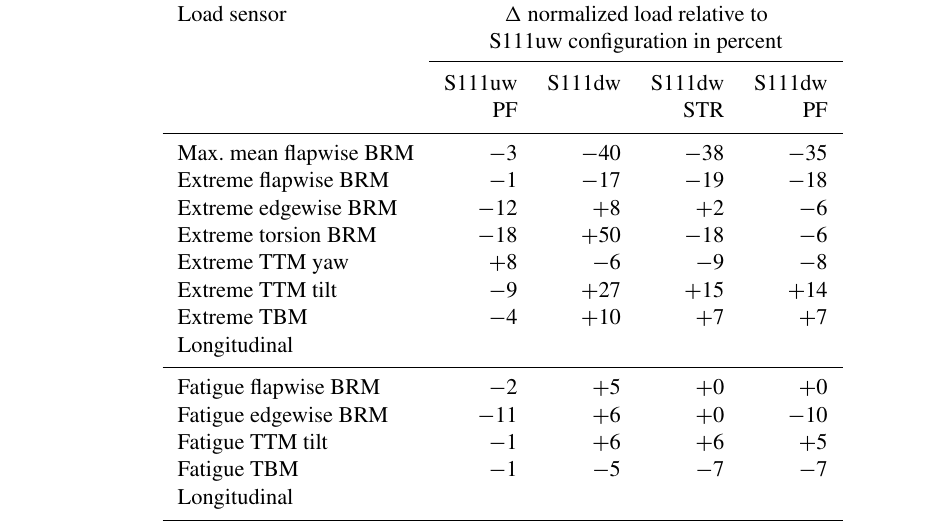
Table 3. Turbine loads for mass and cost drivers. Blade root moment (BRM), tower bottom bending moment (TBM), and tower top moment (TTM). Load sensor (cid:49) normalized load relative to